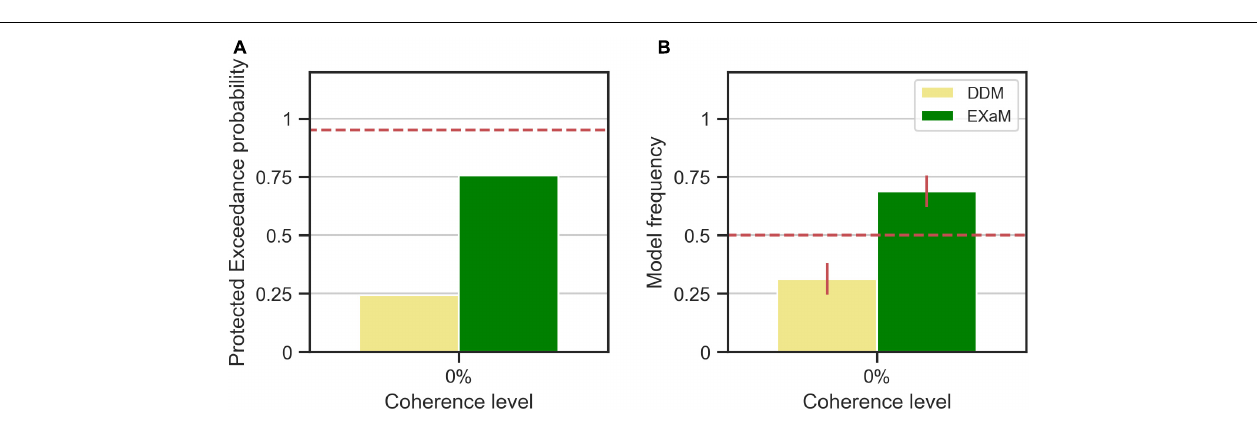
(10%, 25%, 35% coherence) ( Supplementary Figure 1 ).